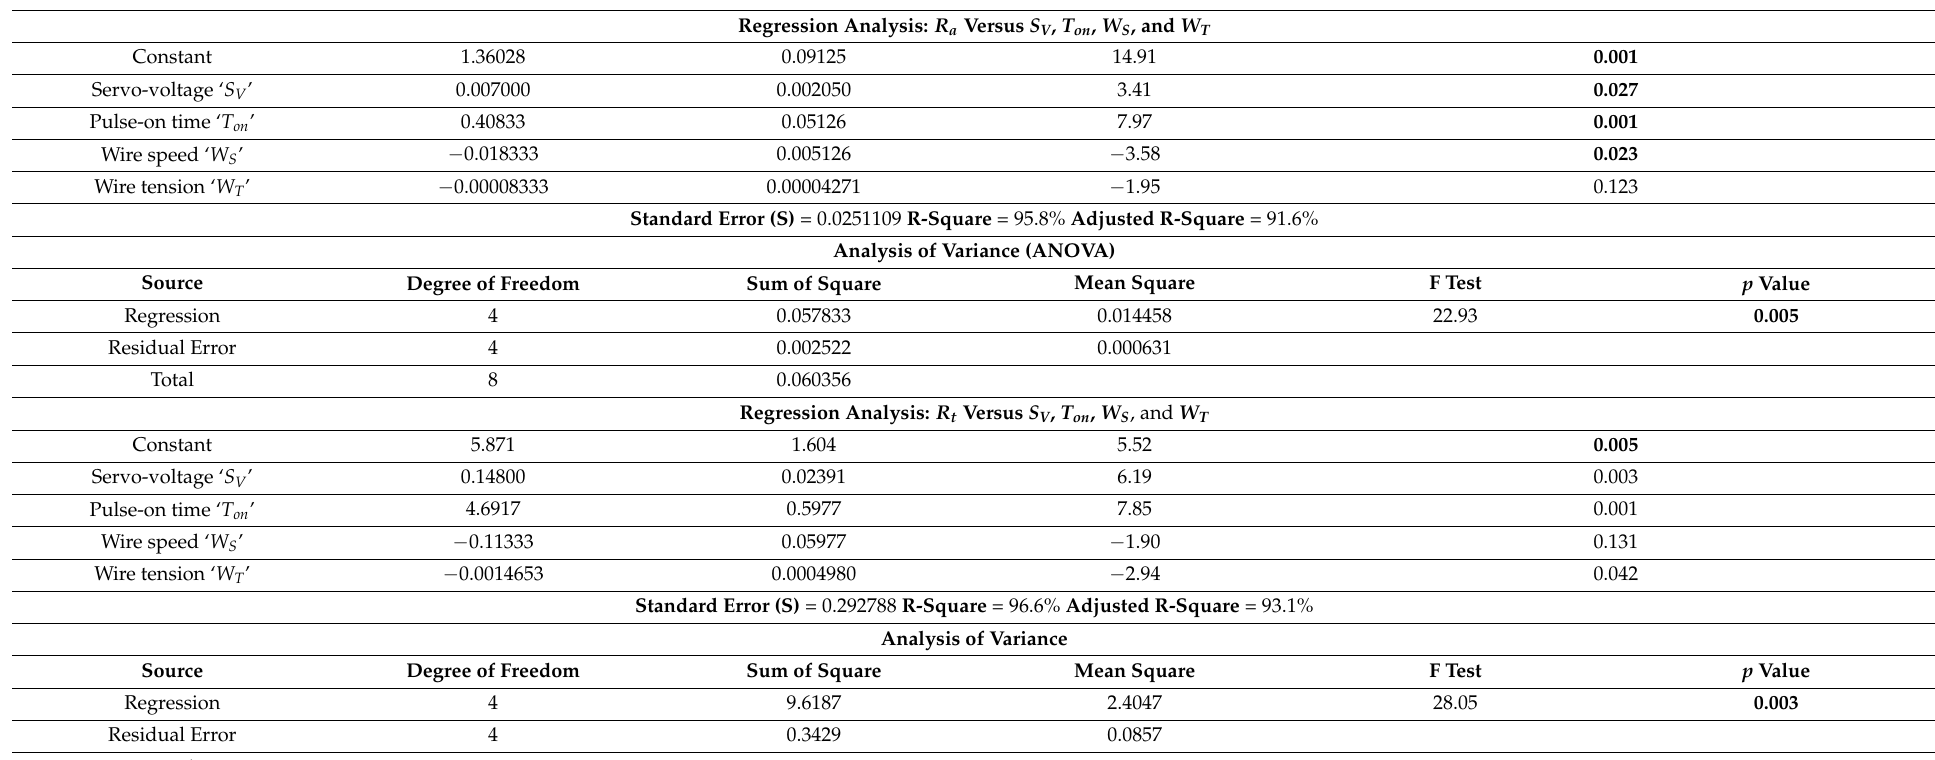
Regression Analysis: R a Versus S V , T on , W S , and W